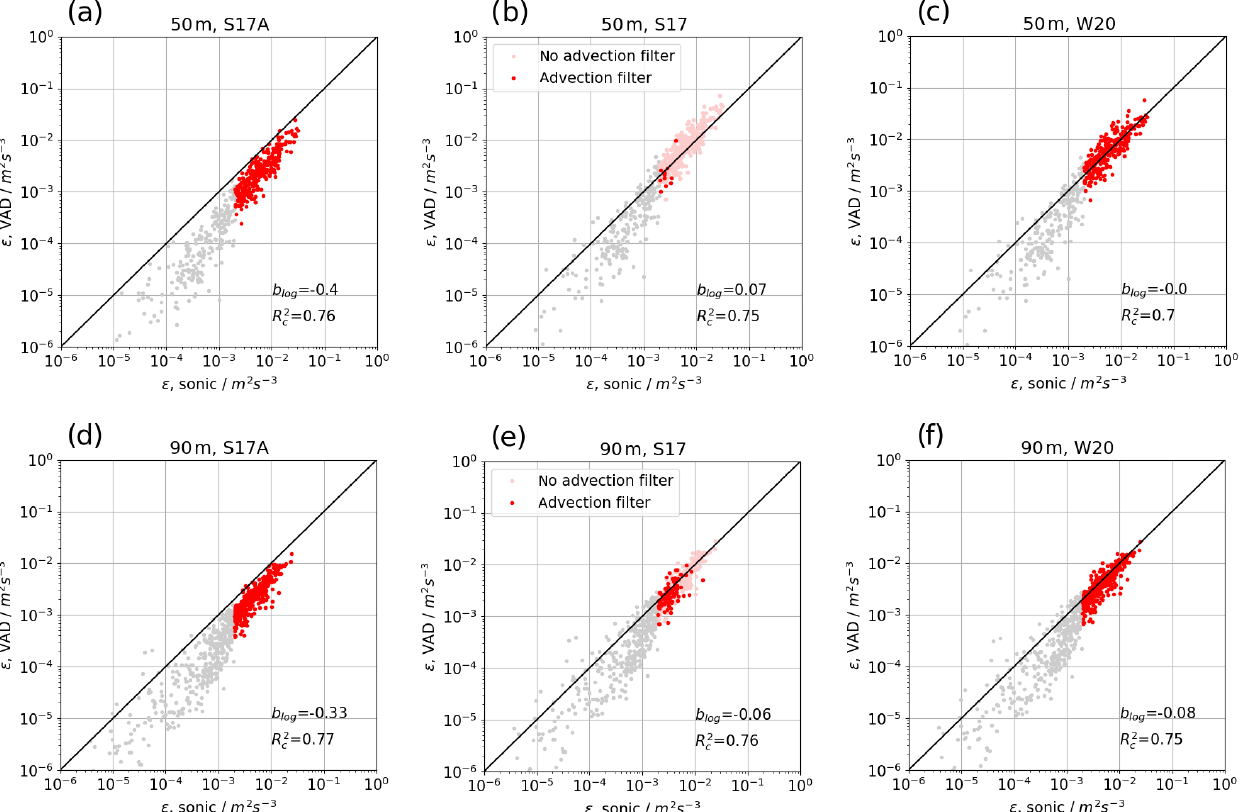
Figure 7. Scatterplot of lidar dissipation rate retrieval against the sonic anemometer dissipation rate. The light red dots in panels (b) and (e) show the results with no advection filter. The light grey dots are all estimates below 2 × 10 − 3 m 2 s − 3 . Grey dots are not used for the calculation of R and b log